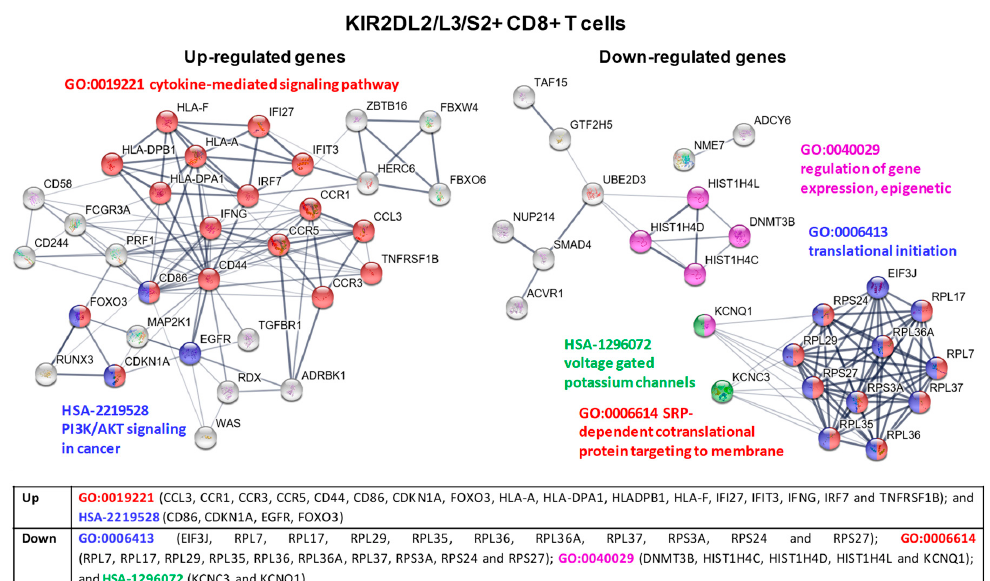
Figure 8. KIR2DL2/L3/S2+ CD8+ T cell cluster analysis of the protein-protein interaction (PPI)